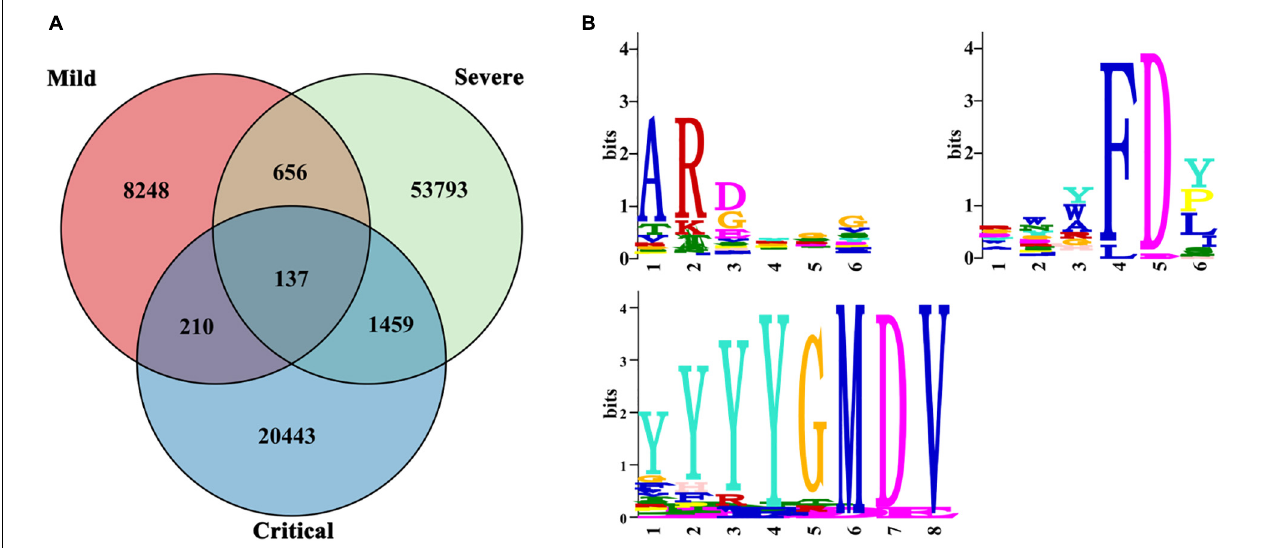
FIGURE 6 | Public IGH clones. Public IGH clones among SARS-CoV-2-infected patients. (A) Clonal overlap among mild ( n = 6), severe ( n = 9), and critical ( n = 10) patients. (B) Multiple EM for Motif Elicitation (MEME) motif for three common motifs: ARDYGG, RWYFDY, and YYYYGMDV. The relative size of each amino acid symbol is proportional to its frequency, while the total height of amino acid symbols indicates the information content of the position in